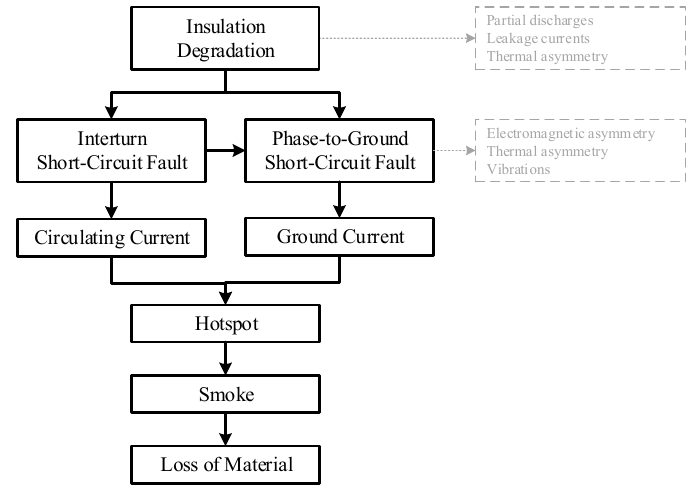
Figure 2. Illustration of stator winding insulation failure mechanism.